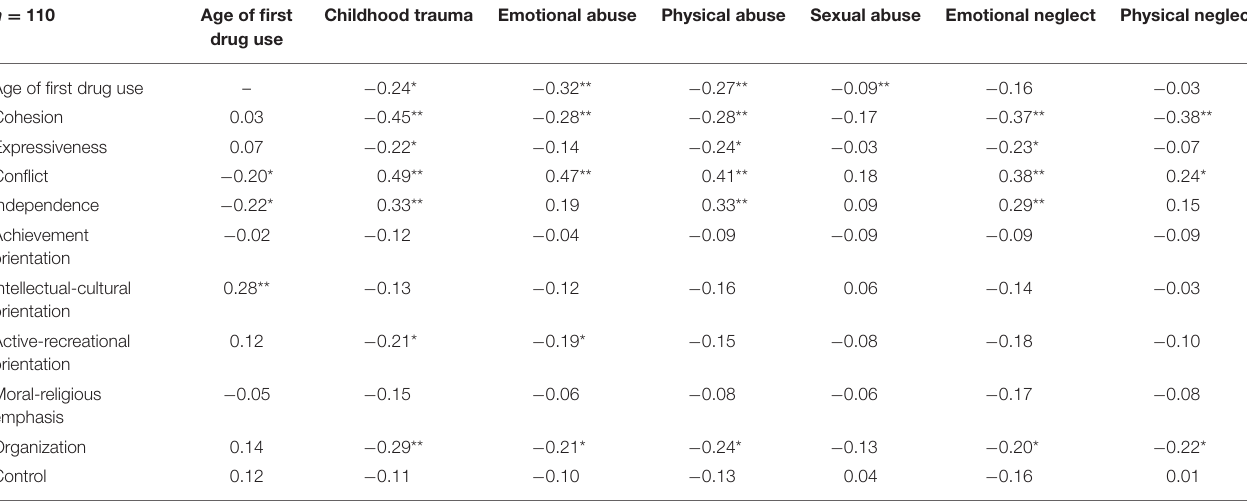
TABLE 2 | Correlation between childhood trauma, family environment and age of first-time drug use. n = 110